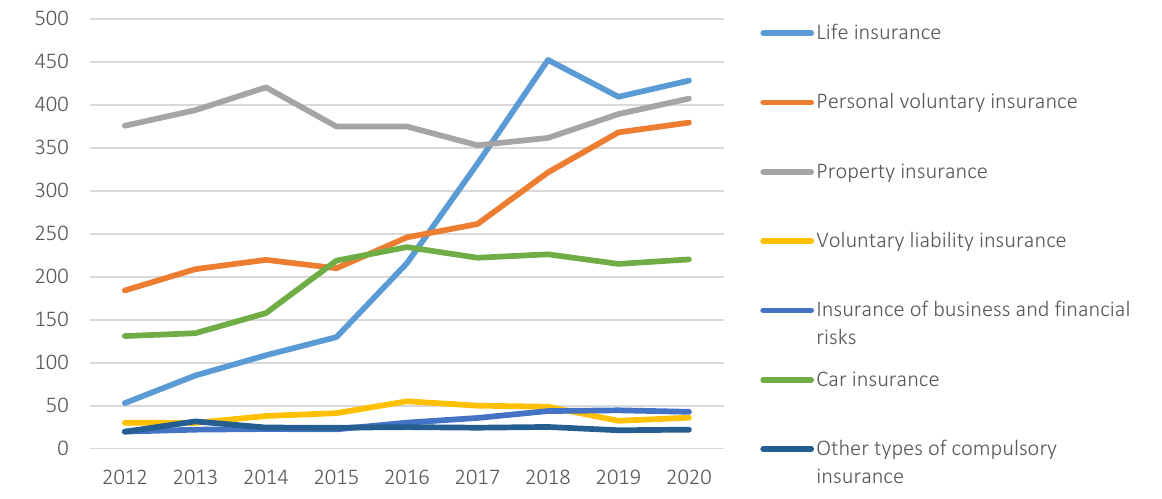
Figure 3. Dynamics of insurance premiums in Russia, billion